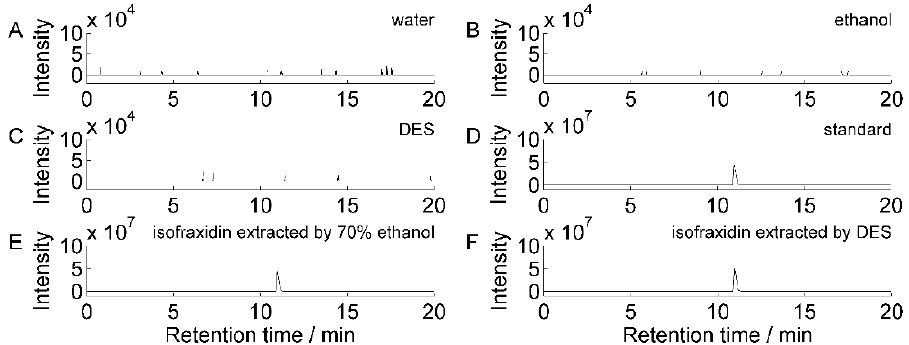
Figure 2. Chromatogram of extracted ions of isofraxidin [M + H] + ( m/z : 223.05977). ( A ) Chro- matogram of the aqueous solution as a blank solvent; ( B ) chromatogram of the ethanol blank solvent; ( C ) chromatogram of the DES blank solvent; ( D ) chromatogram of the reference standard sam- ples of isofraxidin; ( E ) chromatogram of 70% ethanol-extracted isofraxidin; ( F ) chromatogram of DES-extracted isofraxidin.